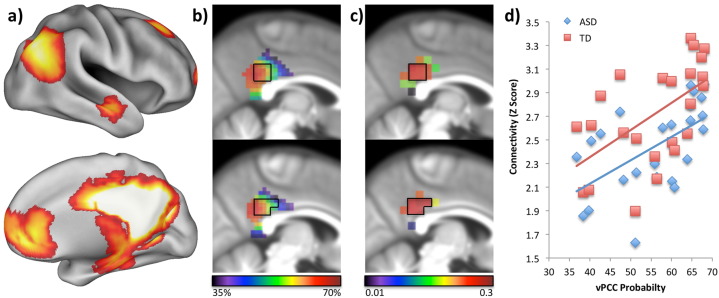
Varying seed placement and its relationship to group difference detection. A) vPCC connectivity fingerprint, putatively the DMN. B) vPCC probability map and C) group differences (effect size) at each 4 mm radius sphere. Black/purple indicates a low probability/effect size with yellow/red indicating a high probability/effect size. Slices in (b) and (c) are taken from X = − 2 (upper panel) and X = 5 (lower panel). The black outline indicates where there were significant group differences (TD > ASD). D) Scatter plot showing the correlation between network strength (Z score) and vPCC probability for each group.